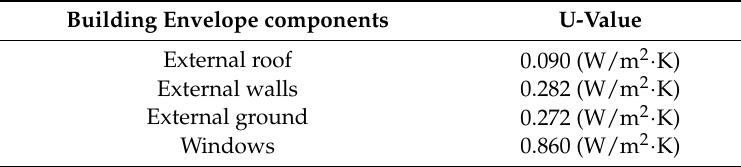
Table 2. U-value of building envelope components used in the